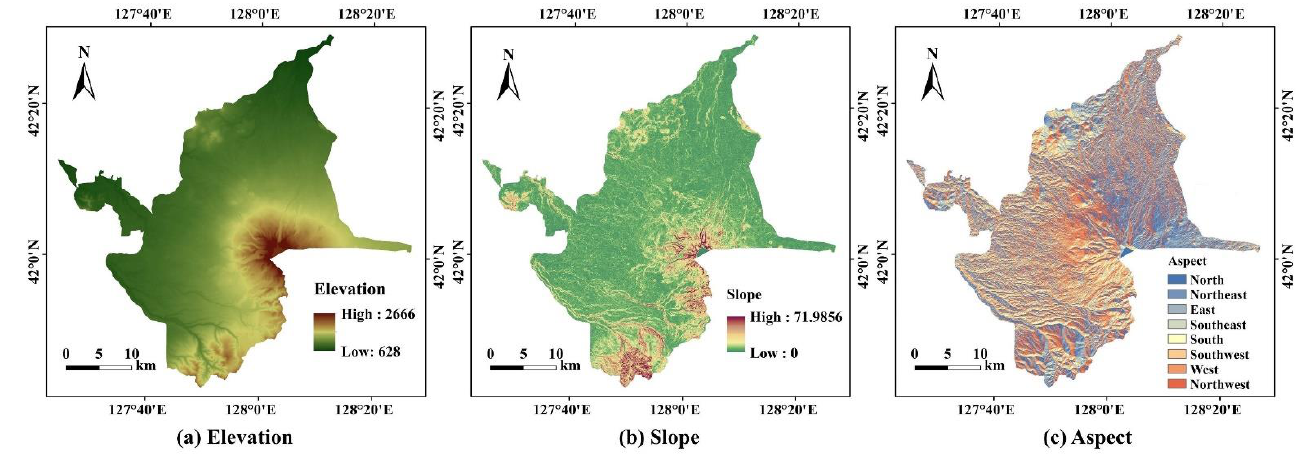
Figure 4. Topographic